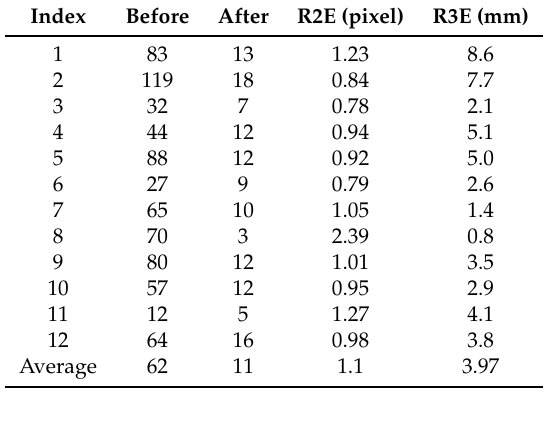
Table 3. Relative 2D error (R2E) and Relative 3D error (R3E) of estimated poses of 12 pairs of RGB-D cameras in Figure 2a when dist _ thresh / min _ dist is set to 2.0, re-projection error is set to 0.1 pixel. “Before” and “After” indicate the number of matched keypoints before and after applying the RANSAC-based filtering method respectively.